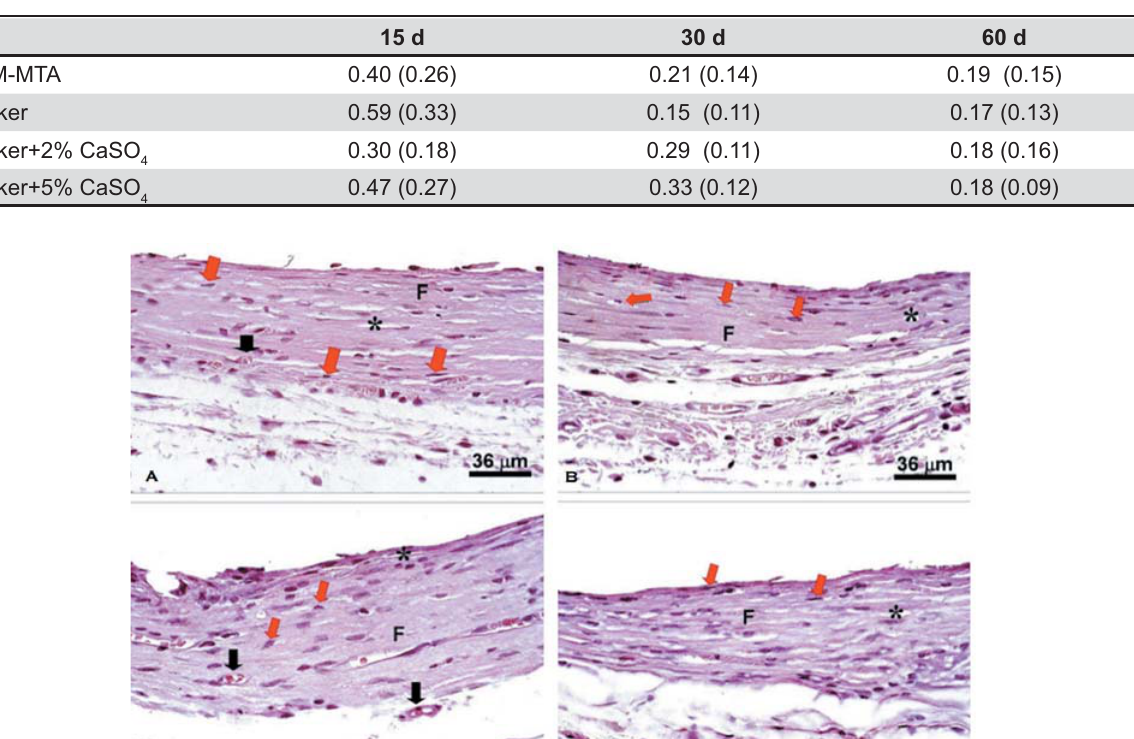
Table 2- (cid:2)(cid:3)(cid:4)(cid:5)(cid:6)(cid:2)(cid:9)(cid:21)(cid:2)(cid:15)(cid:4)(cid:6)(cid:7)(cid:12)(cid:11)(cid:19)(cid:2)(cid:22)(cid:9)(cid:20)(cid:14)(cid:18)(cid:4)(cid:2)(cid:23)(cid:24)(cid:25)(cid:2)(cid:5)(cid:6)(cid:15)(cid:2)(cid:7)(cid:11)(cid:5)(cid:6)(cid:15)(cid:5)(cid:10)(cid:15)(cid:2)(cid:15)(cid:4)(cid:22)(cid:12)(cid:5)(cid:11)(cid:12)(cid:9)(cid:6)(cid:2)(cid:9)(cid:21)(cid:2)(cid:12)(cid:6)(cid:17)(cid:5)(cid:18)(cid:18)(cid:5)(cid:11)(cid:9)(cid:10)(cid:19)(cid:2)(cid:8)(cid:4)(cid:20)(cid:20)(cid:7)(cid:2)(cid:7)(cid:16)(cid:9)(cid:26)(cid:6)(cid:2)(cid:12)(cid:6)(cid:2)(cid:8)(cid:9)(cid:6)(cid:6)(cid:4)(cid:8)(cid:11)(cid:12)(cid:22)(cid:4)(cid:2)(cid:11)(cid:12)(cid:7)(cid:7)(cid:14)(cid:4)(cid:2)(cid:23)(cid:8)(cid:5)(cid:27)(cid:7)(cid:14)(cid:20)(cid:4)(cid:25)(cid:2)